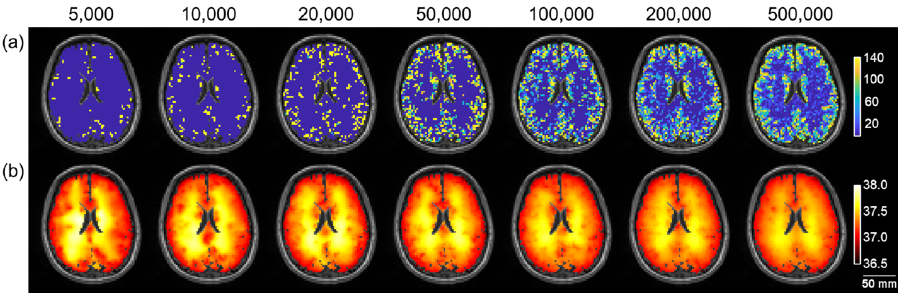
Fig. 3 Effect of rapidly exploring random tree (RRT) iterations on predicted cerebral blood fl ow (CBF) and brain temperature. a Increasing the number of RRT iterations resulted in reduced and more realistic CBF values. Maximum CBF after 5000, 20,000, 100,000, and 500,000 RRT iterations (indicated at the top of each column) was 3901.3, 1326.4, 506.9, and 270.4 mL 100 g − 1 min − 1 , respectively. CBF color bar ranges from 0 to 140 mL 100 g − 1 min − 1 . b Changes in CBF distribution due to increased RRT iterations subsequently affects model-predicted brain temperature. More uniform temperatures were observed after more RRT iterations. The temperature color bar ranges from 36.5 to 38.0 °C. The scale bar is 50 mm and all the images are on the same